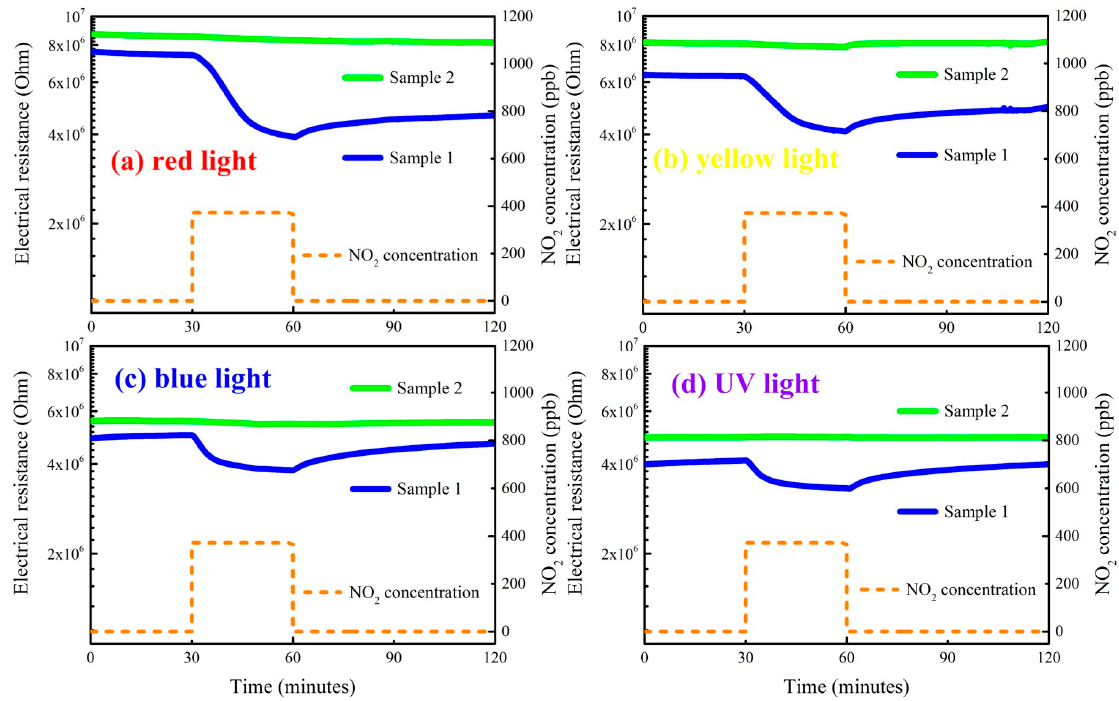
Figure 5. The electrical resistance of Sample 1 and 2 versus 372 ppb NO 2 gas under different light illumination at room